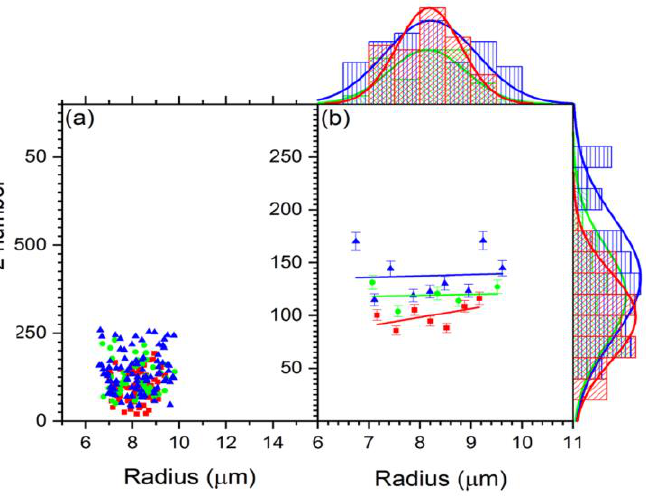
Figure 6. ( a ) The scatter plot of the charge distribution with size for control (red), 2 h-treated (green), and 24 h-treated (blue) group. ( b ) Reduced data for the charge vs. R using Origin data manipulation reduction by grouping for control (red), 2 h-treated (green), and 24 h-treated (blue). The charge is measured by the z number.